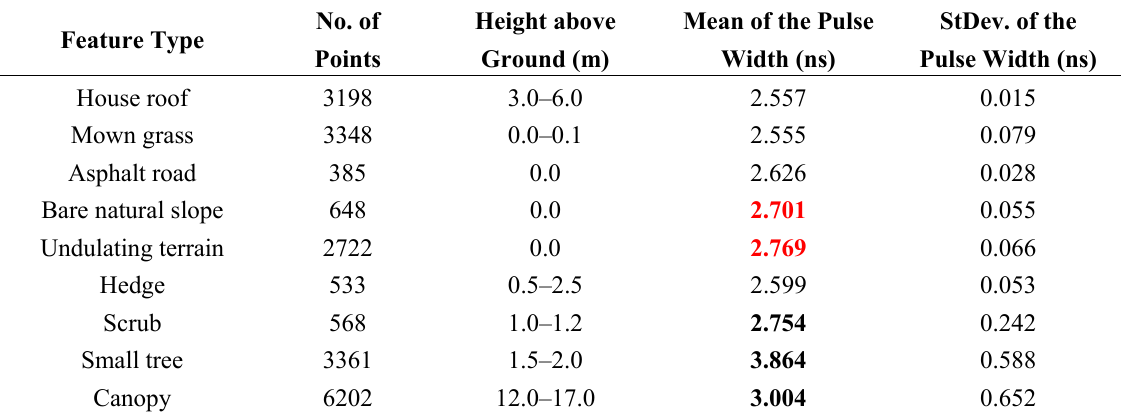
Table 1. Pulse width analysis for the tested dataset. Values highlighted in bold and italic represent categories with a mean pulse width > 2.69